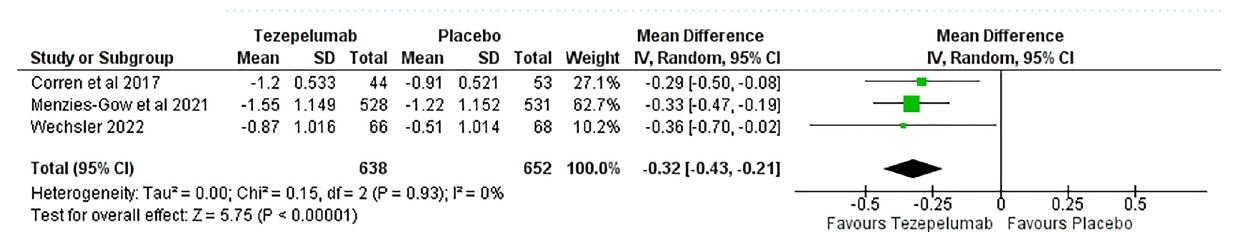
Figure 5. Change from the baseline in Pre-dose/pre-bronchodilator (pre-BD) forced expiratory volume in 1 s (FEV1).